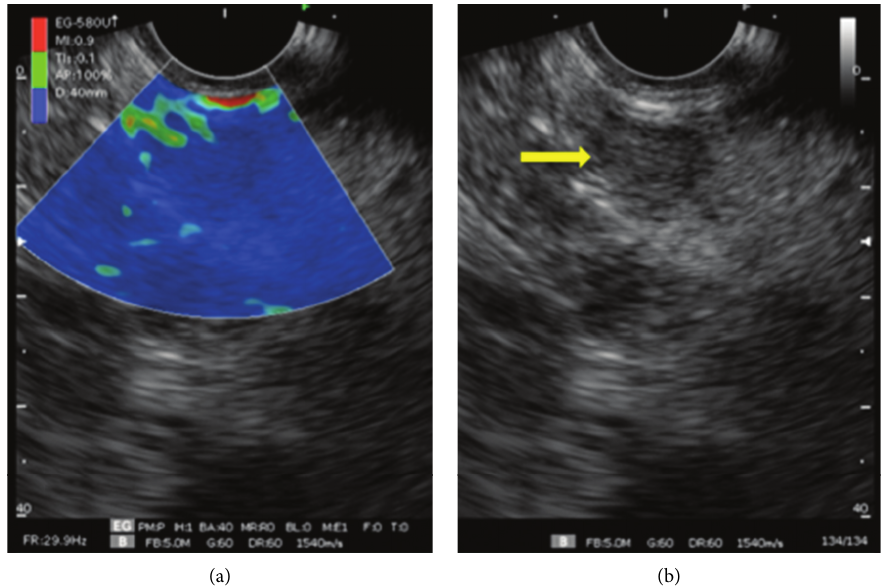
Figure 2: Elastography performed with a sectorial endoscopic ultrasound device. (a) Elastography of uncinate hardened process lesion (blue image). (b) Yellow arrow indicating hypoechoic lesion of uncinate process.